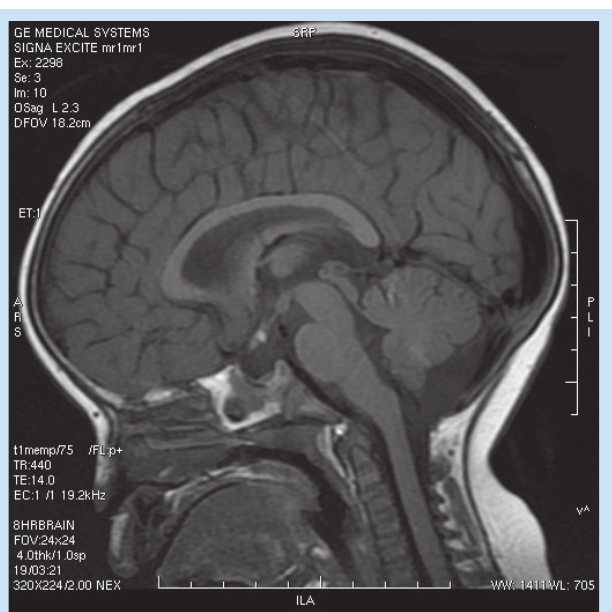
Fig. 3b. A coronal T1W MRI scan demonstrating the hyperintense central ectopic posterior pituitary, and the absent septum pellucidum. The pituitary stalk was not